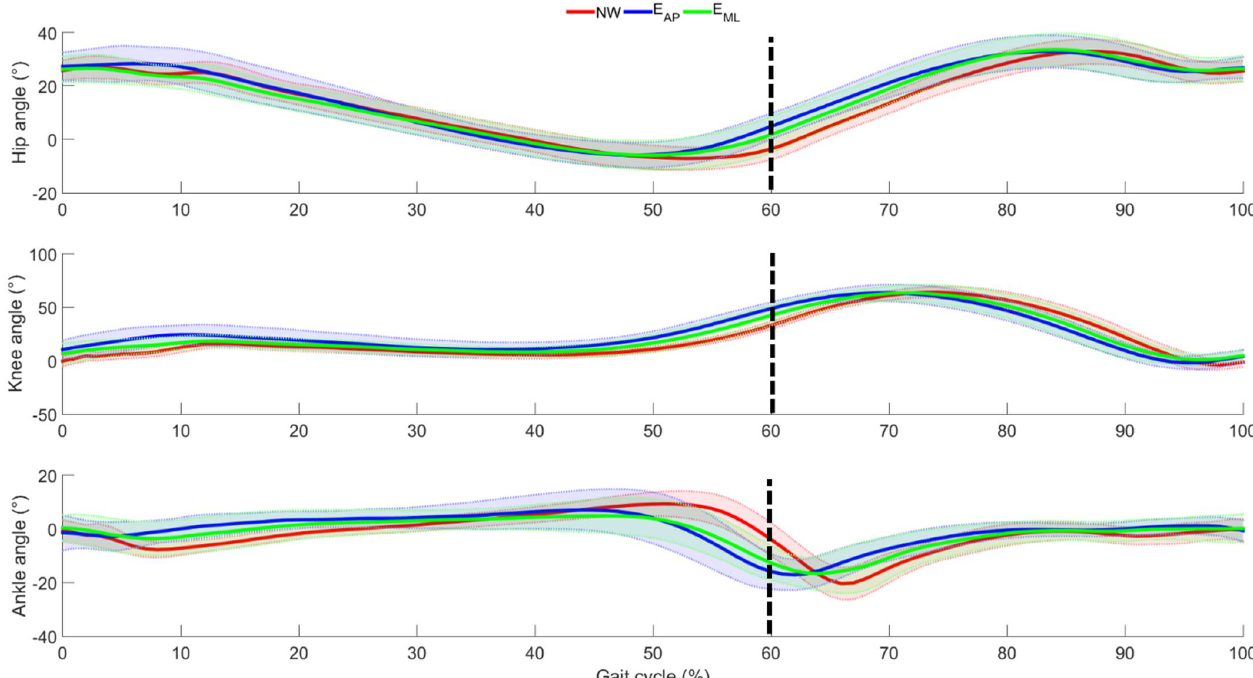
Figure 3. Mean (bold line) and standard deviation (shaded area) of the lower limb joint angles as averaged across participants. Red, blue, and green are used to identify the normal walking, the perturbed locomotion in anterior-posterior direction, and the perturbed locomotion in medio-lateral direction, respectively. The dotted, black line represents the transition between stance and swing phases in NW.